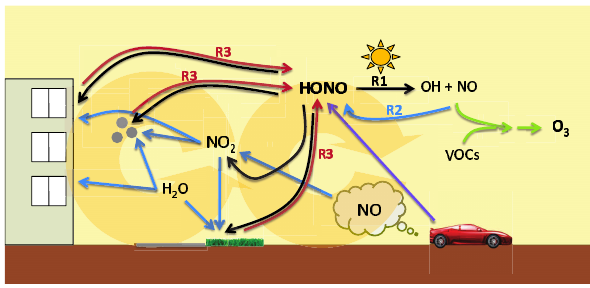
Fig. 1. Schematic figure of HONO chemistry in urban boundary layer, showing HONO formation from direct emission (purple arrow), gas-phase Reaction (R2) (cyan arrow) and heterogeneous Reaction (R3) (blue and red arrows). HONO loss processes such as photolysis (Reaction R1) and uptake on surfaces are indicated by black